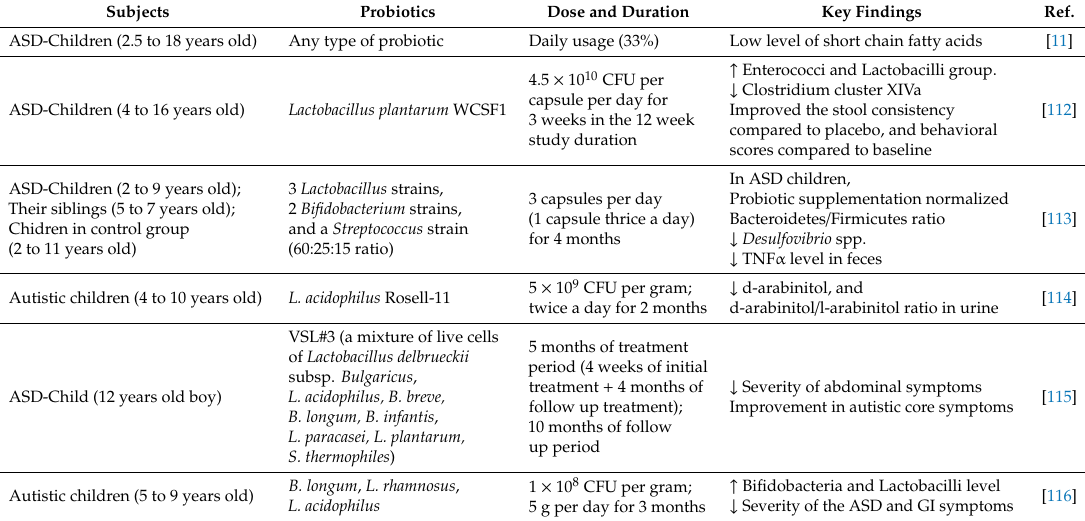
Table 1. The e ff ect of probiotic supplementation on the health status of individuals with ASD. Subjects Probiotics Dose and Duration Key Findings